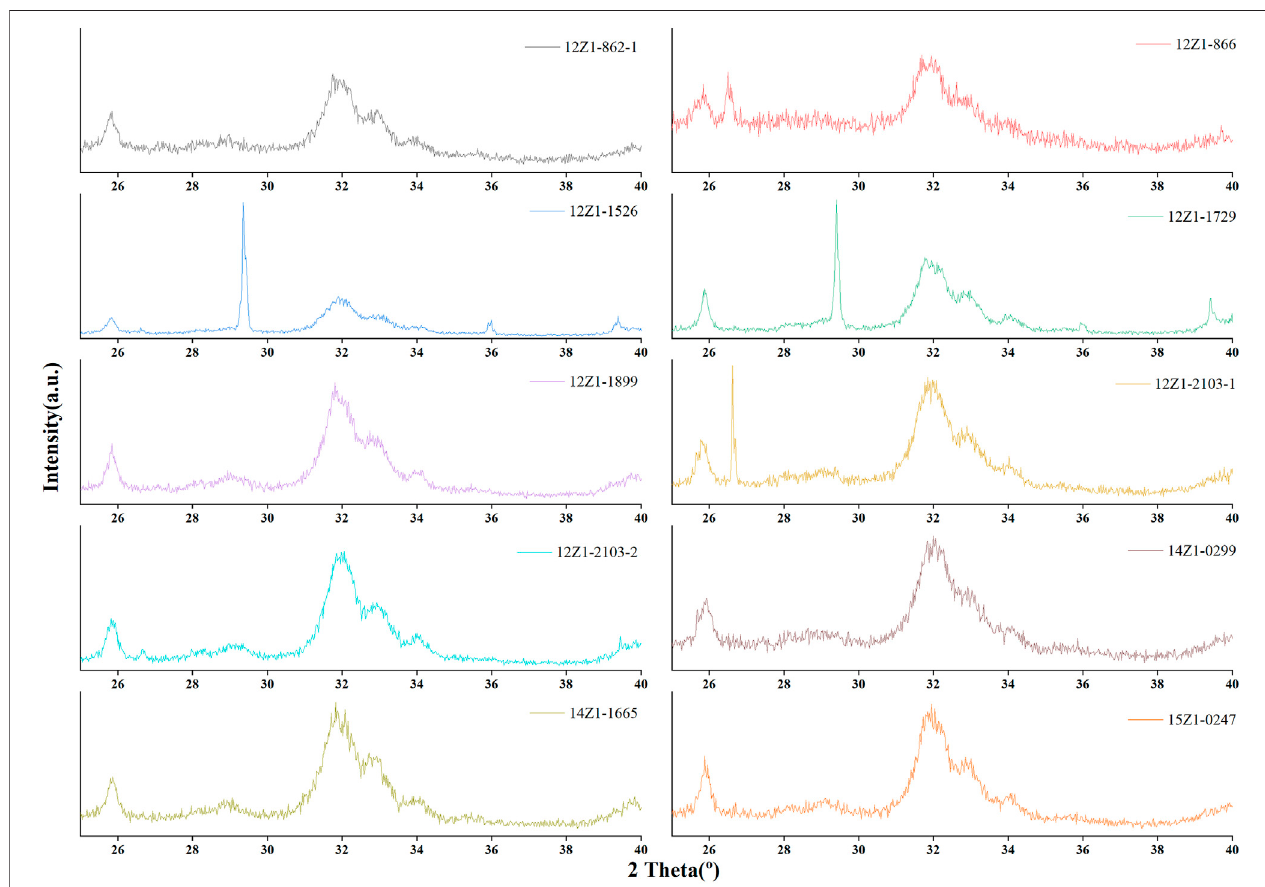
FIGURE 7 | XRD pattern of fossil bone with a lower crystallinity ( < 0.3) of hydroxyapatite.